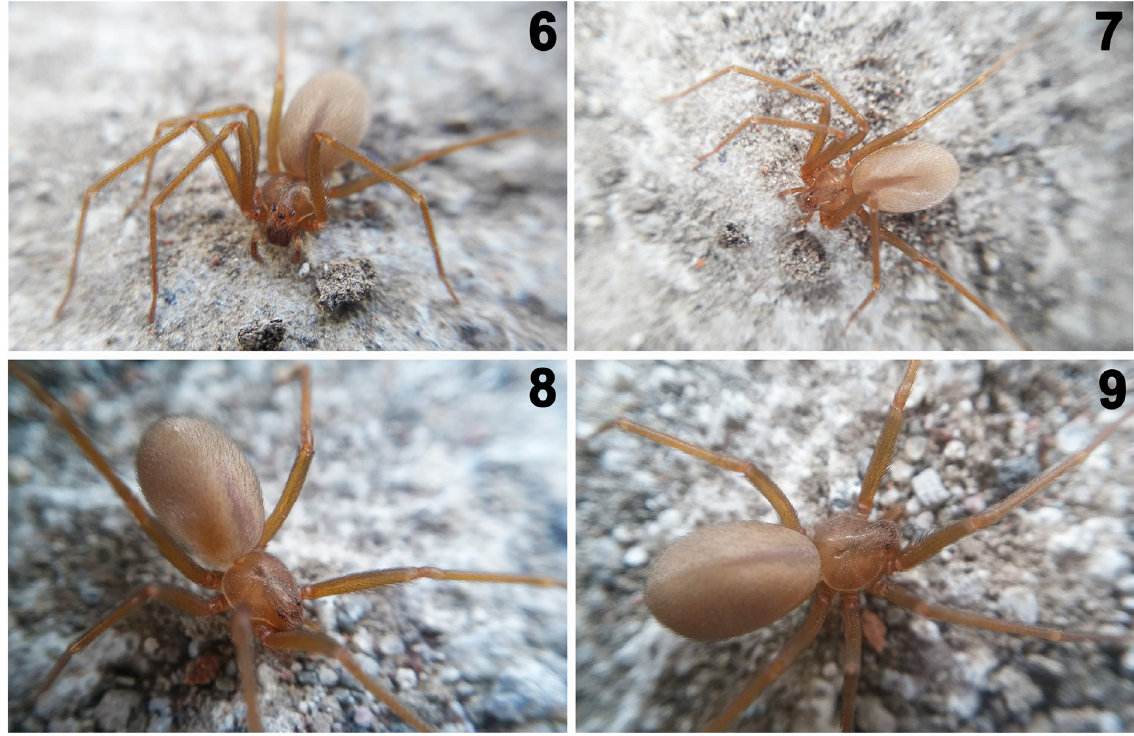
Figs 6–9. Live female paratype (CNAN-T01321) of Loxosceles tolantongo sp. nov. from the type locality: Tourist Center Grutas de Tolantongo Municipality of Cardonal, Hidalgo, Mexico. Photos 6–7 by Alejandro Valdez-Mondragón (2019); photos 8–9 by Claudia Isabel Navarro-Rodríguez